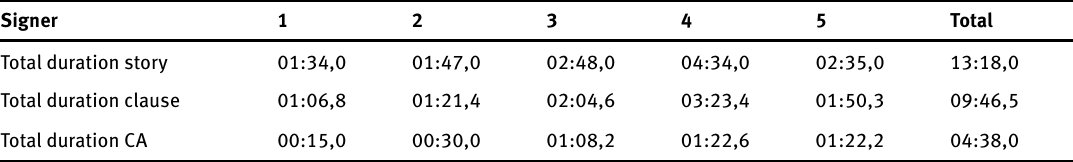
Table 1. Summary of the total signer-specific and combined durations for the story, clause and CA.